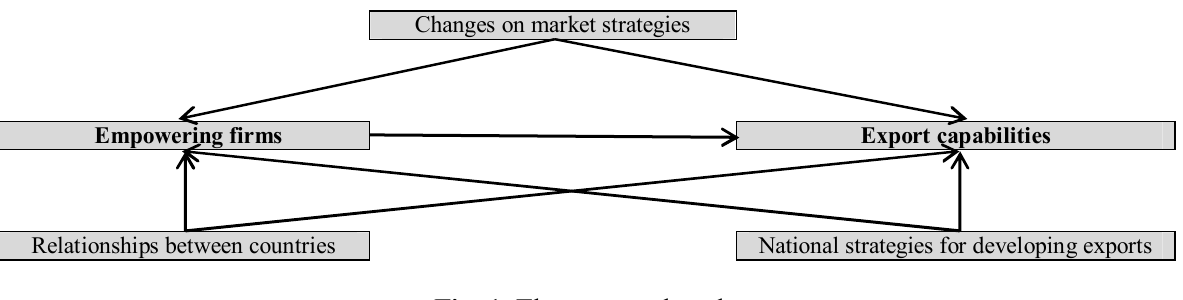
Fig. 1. The proposed